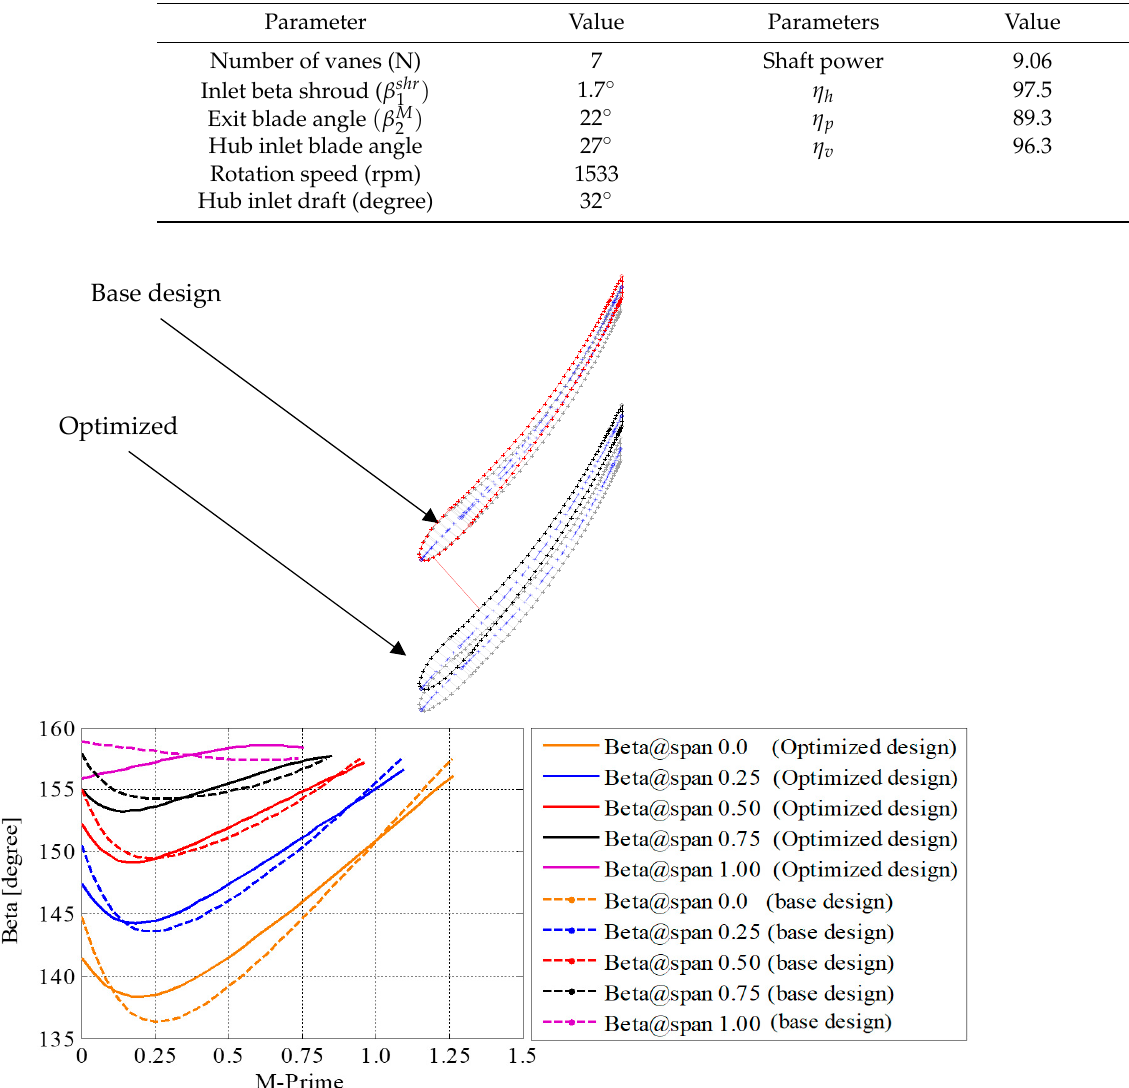
Figure 5. Comparison between base geometry and optimized geometry.